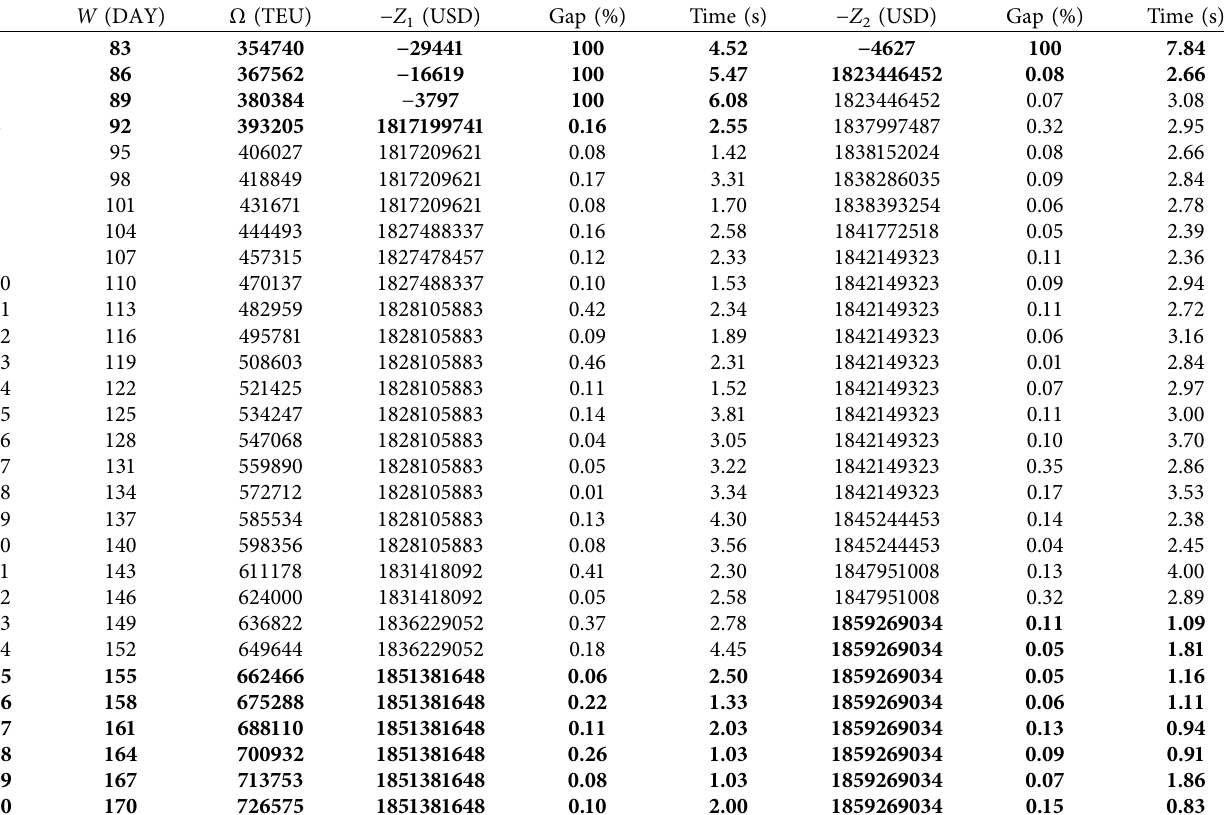
Table 2: The test results of 30 different { W , Ω }